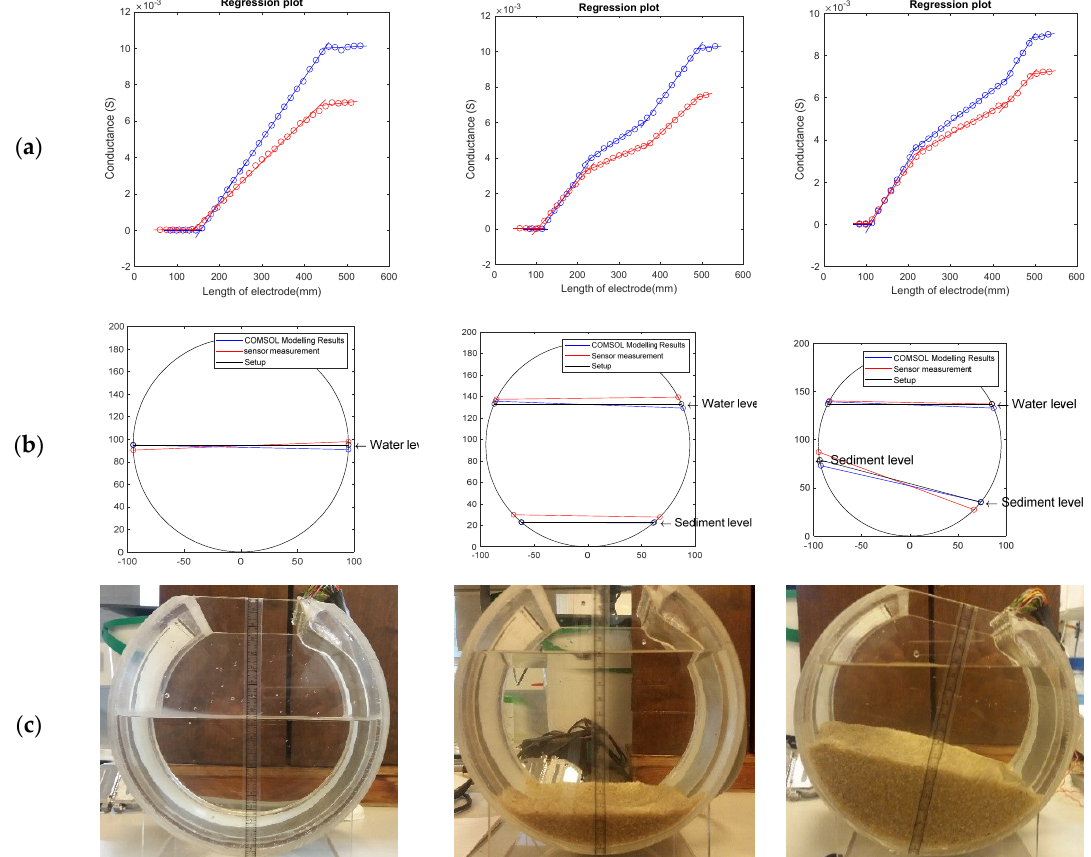
Figure 9. Test W2, S1, and SA1: ( a ) the fitting results of these three tests (blue line: COMSOL modelling results; red line: sensor’s measurement results); ( b ) the calculated depths demonstrated in the circle; ( c ) photograph of the setup in the experiment.